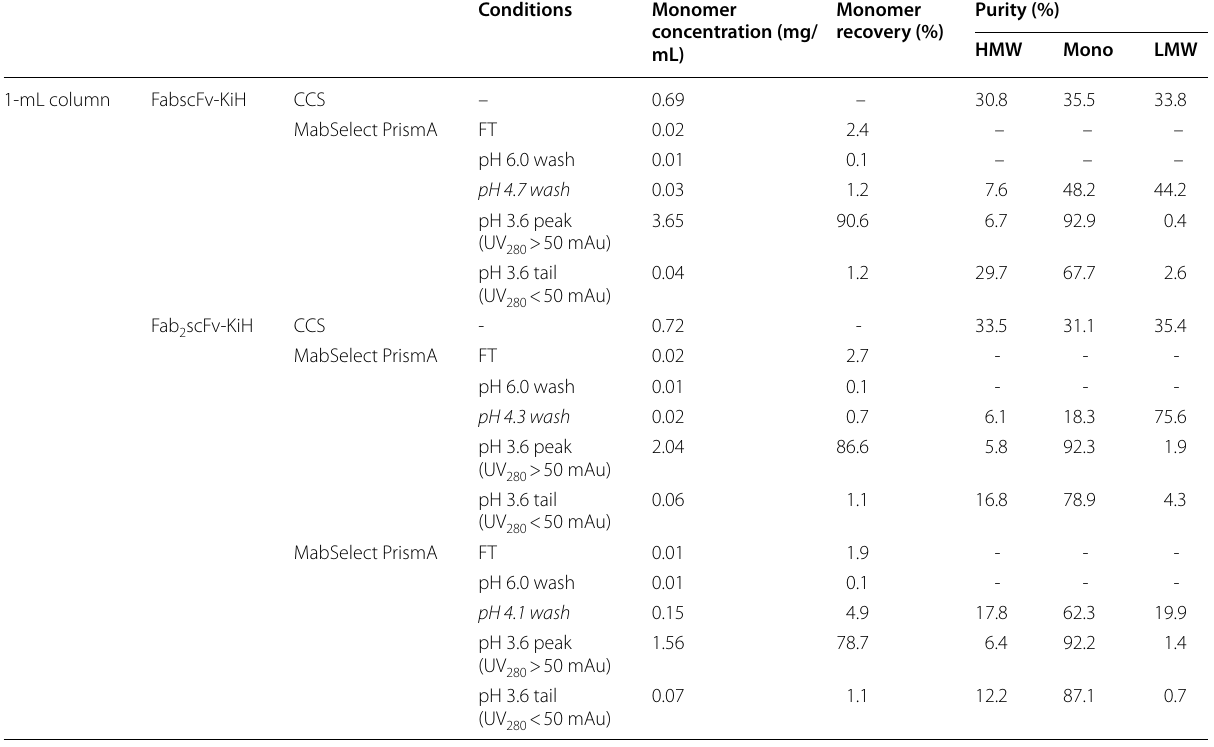
Table 3 The purity profile, monomer concentration and recovery of each step of the Protein A run for both FabscFv-KiH and Fab KiH in 1-mL columns with a load of 50% of QB10 at 6-min residence time, with the introduction of an intermediate low-pH wash step